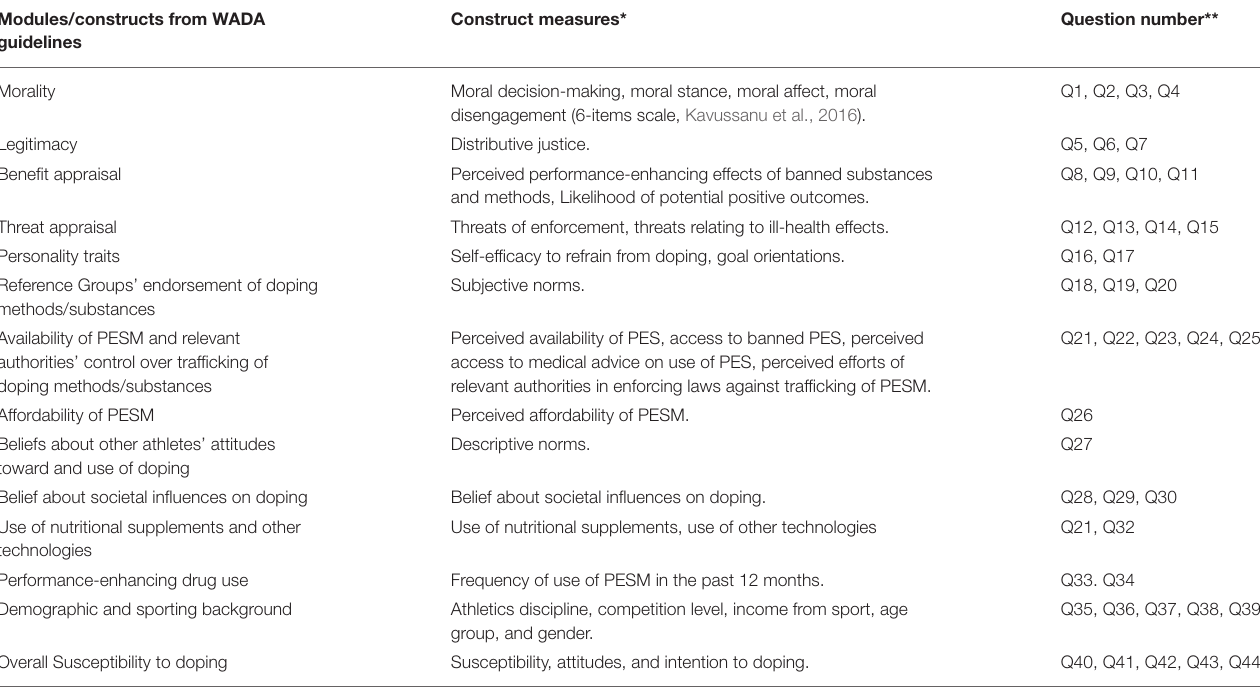
TABLE 1 | Description of the